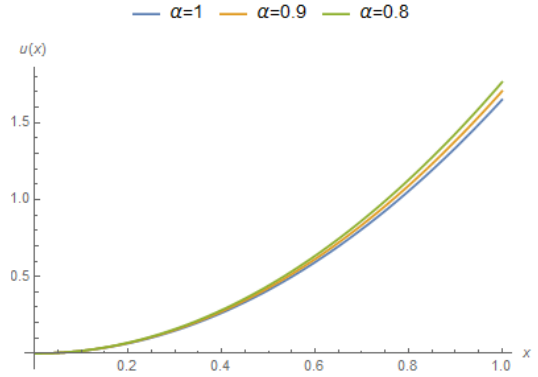
Figure 5:2D Solutions of example1 for Figure 10. 2D Solutions of Example 2 for different values of α di⁄erent values of (cid:11)